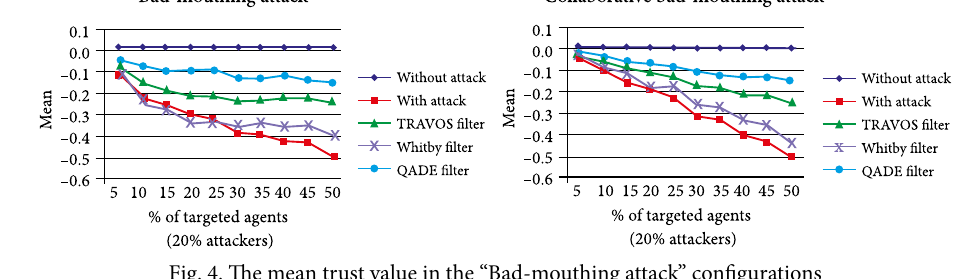
Fig. 4. The mean trust value in the “Bad-mouthing attack” configurations with different number of targeted agents